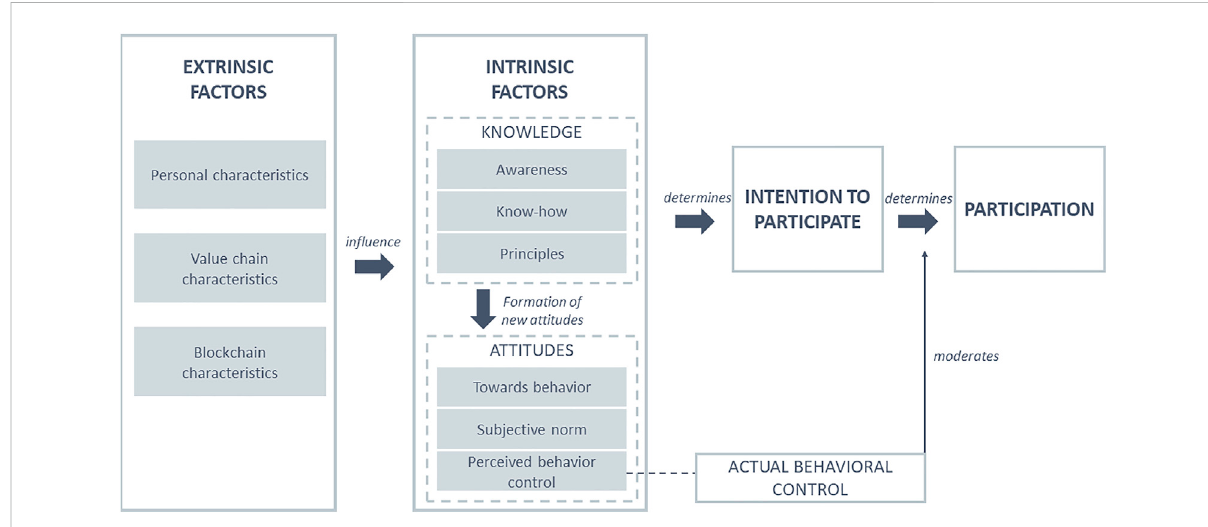
FIGURE 1 Participation Capacity Framework linking the Theory of Planned Behavior (Ajzen, 1991; Ajzen, 2012; Ajzen and Kruglanski, 2019) and the Diffusion of Innovation theory (Rogers, 2003), based on (Wojewska et al., 2021).